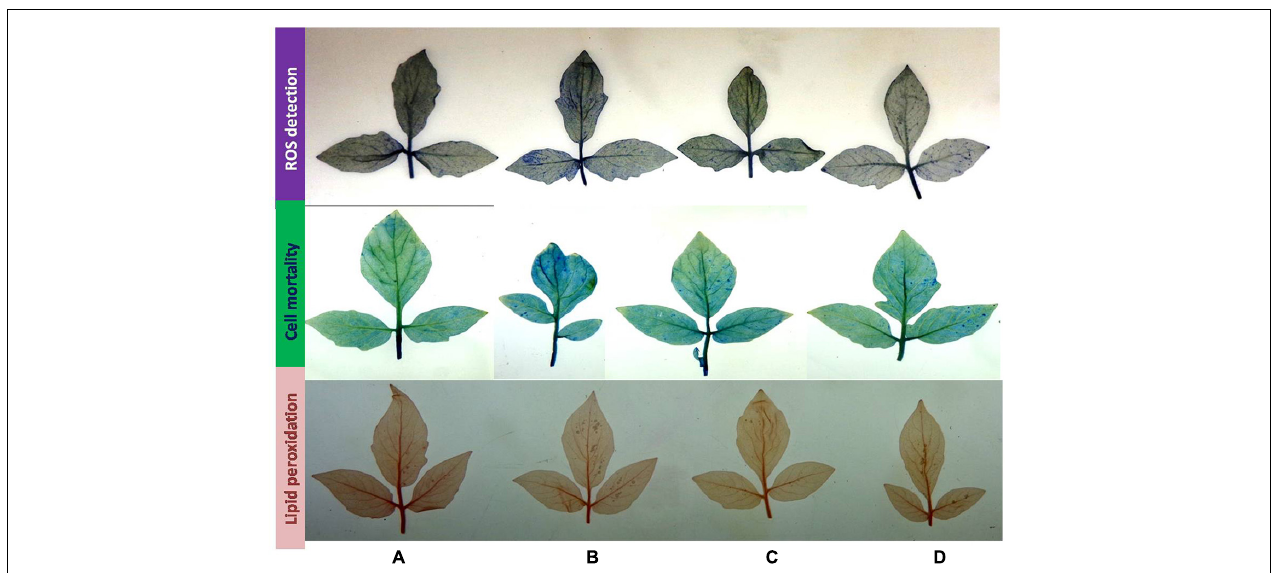
FIGURE 10 | Histochemical analysis of cell death, ROS production, and lipid peroxidation in tomato plant leaves upon bacterial (BHU-AV3) inoculation under salt stress. ROS detection – blue spots show production of superoxide radicals; cell mortality – light blue spots show cell mortality; lipid peroxidation – red spots show lipid peroxidation. (A) Control; (B) salt (NaCl); (C) bacterial (BHU-AV3) inoculation; (D) bacterial inoculation +